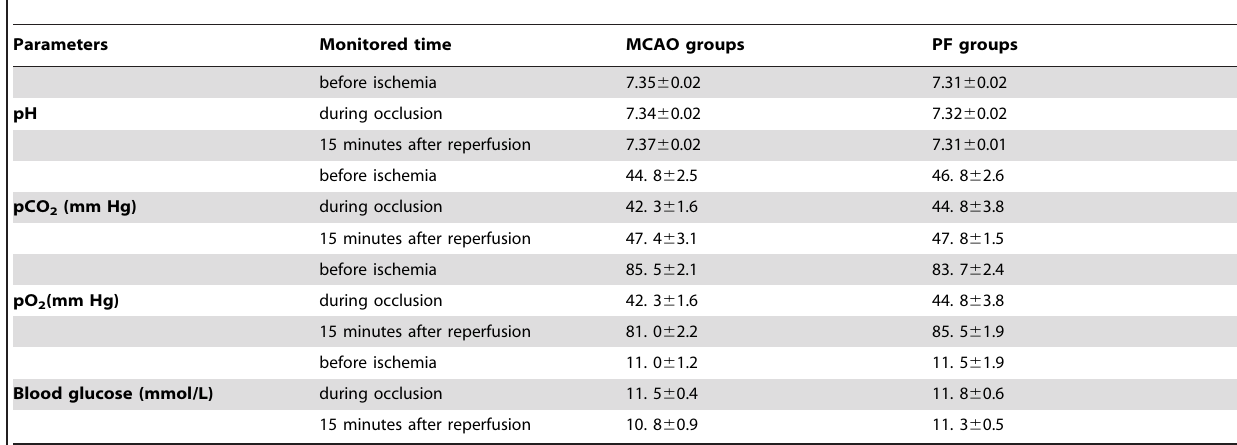
Table 1. Physiologic parameters of rats before, during MCAO or 15 min after saline and PF treatment.